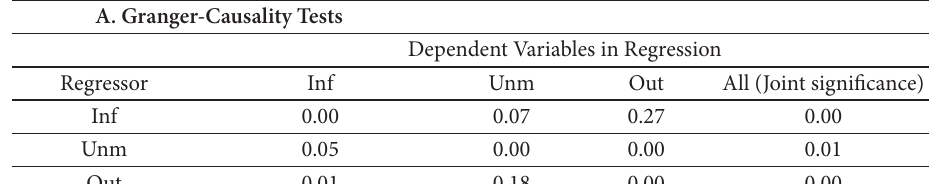
Table 1. VAR Descriptive Statistics for (Inf, Unm,